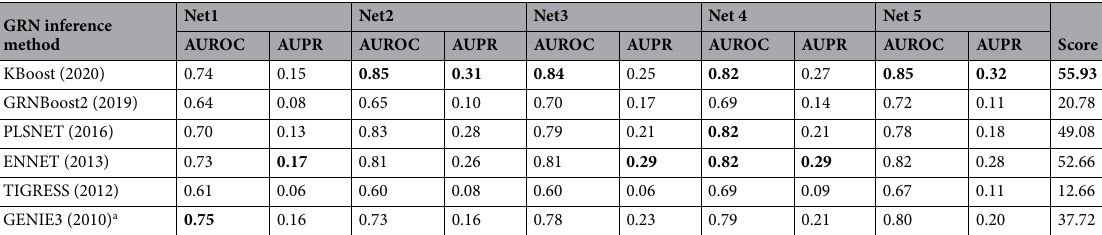
Table 2. DREAM 4 dataset benchmark. a Winner of the DREAM 4 challenge which included 11 algorithms. The best performance in each column is in